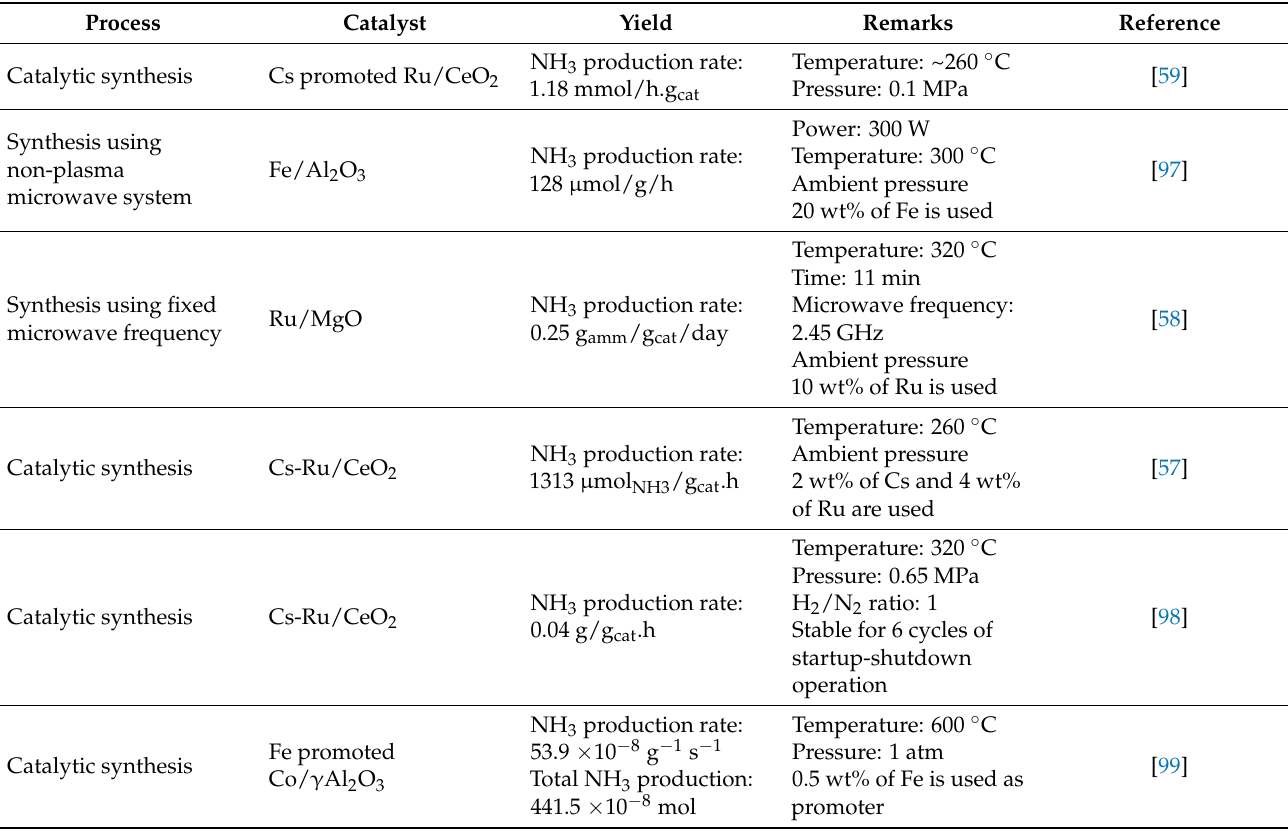
Table 9. Ammonia synthesis using microwave-assisted